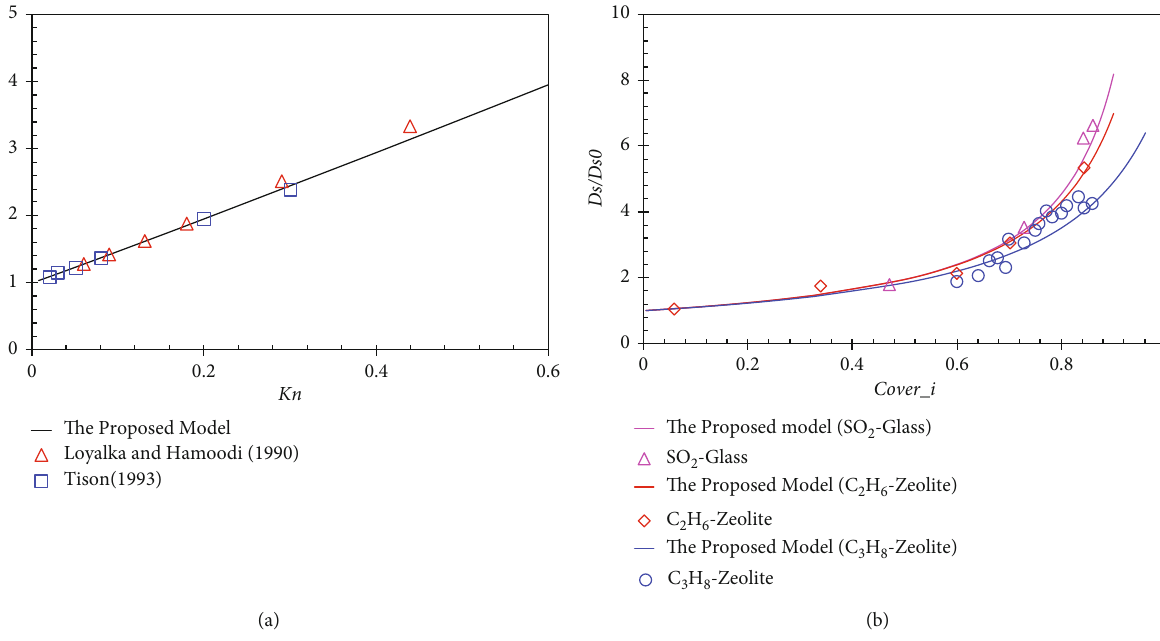
Figure 2: The veri fi cation of the proposed model: (a) the bulk-gas fl ow model utilizing the ratio of nanocon fi ned gas conductance and that for no-slip NS equation; (b) the surface di ff usion model utilizing the di ff usion coe ffi cient ratio. Table 2: The basic parameters to reproduce the surface di ff